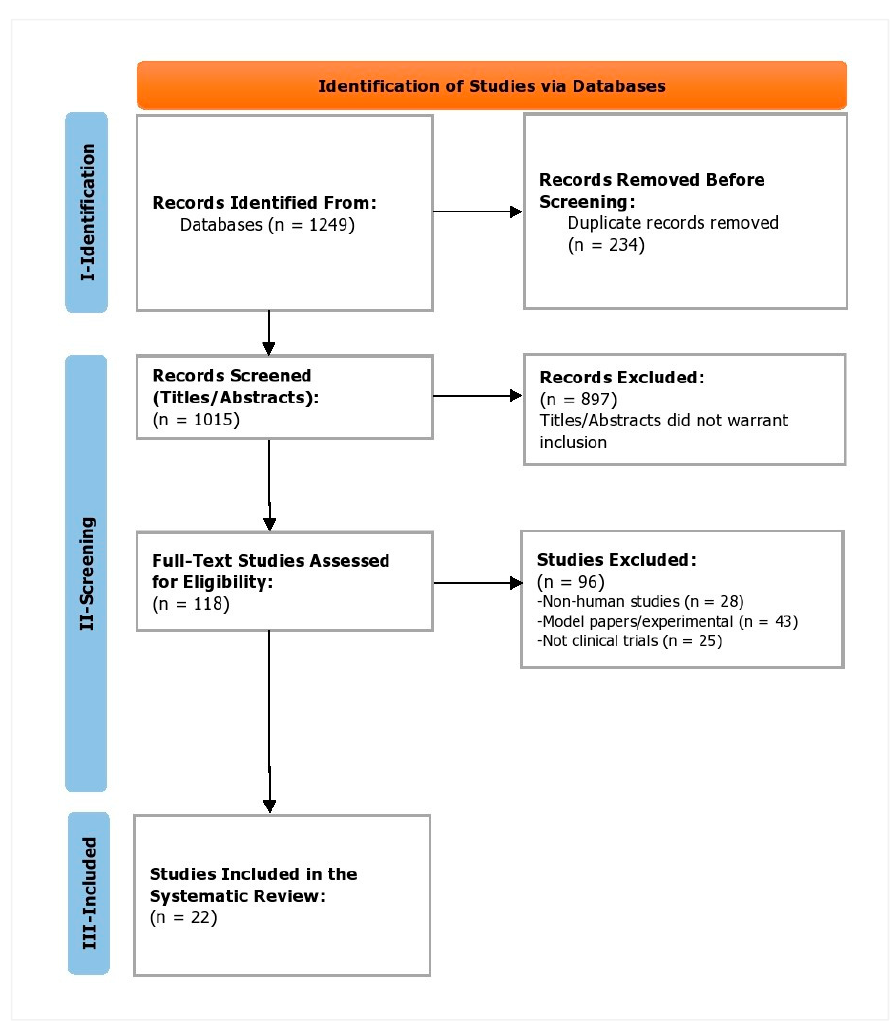
Figure 1. PRISMA flowchart depicting the study selection process.